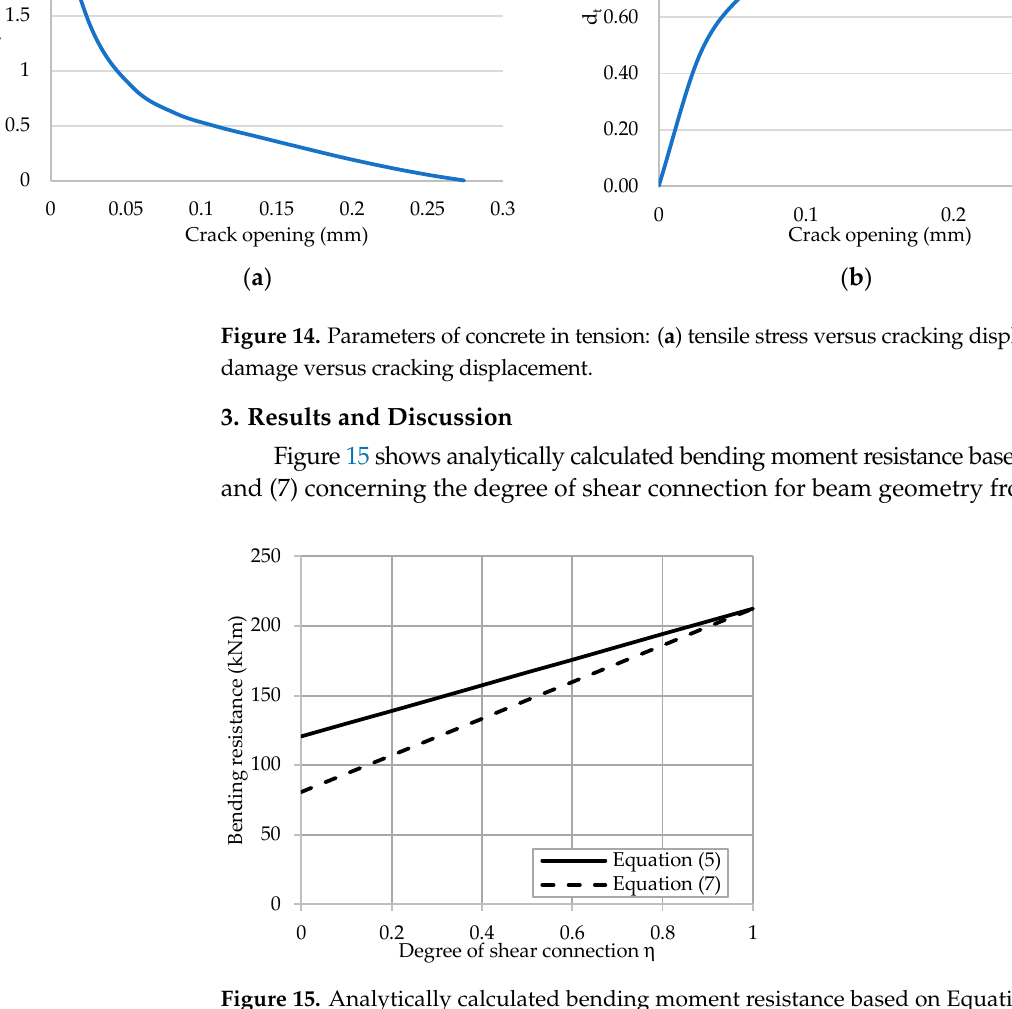
( c ) Figure 16. Differences in end slip between three analysed solutions of pinned beam: ( a ) full tie shear connection; ( b ) shear connectors spaced at 300 mm; ( c ) shear connectors spaced at 600 mm. The bending resistance of the beam in the cases of fully tied shear connection and analysed spot weld solutions, i.e., SW2 and SW3, are presented in Figure 17. Both curves in Figure 17a,b shows that the numerically obtained bending resistance is higher than the analytically calculated bending resistance presented with a dashed horizontal line.